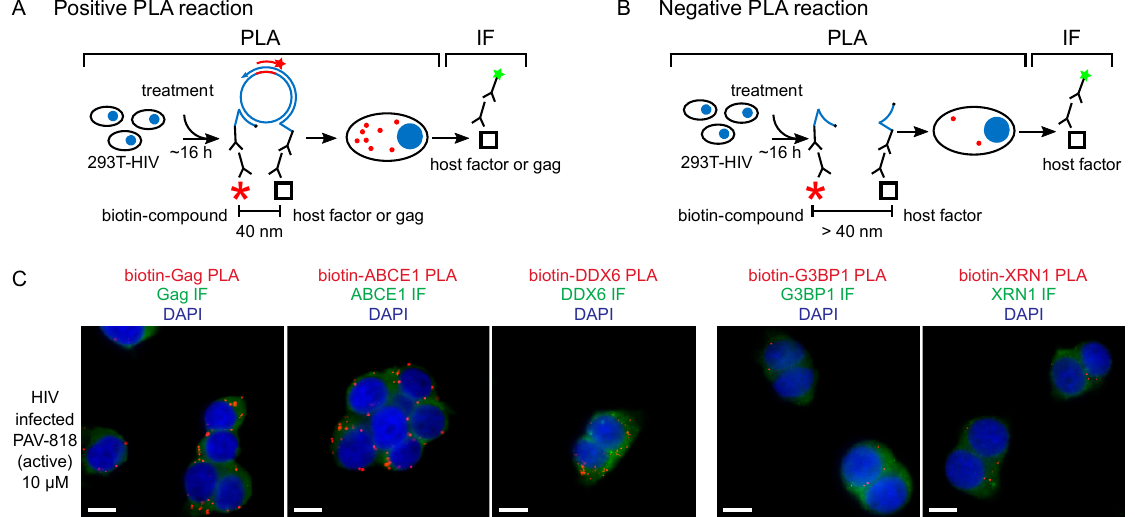
Figure 5. The biotinylated antiretroviral analog of PAV-206 colocalizes with three components of assembly intermediates but does not colocalize with two host proteins that are not associated with Gag or assembly intermediates [29]. ( A ) Schematic of the PLA approach for detecting colocalization of PAV-206 with either Gag or the host proteins ABCE1 and DDX6. 293T cells chronically infected with HIV-1 (293T-HIV) were treated with 10 µ M PAV-818 (the biotinylated active compound). PLA was performed on treated cells by incubating with primary antibody pairs (either rabbit anti-biotin with mouse anti-Gag; mouse anti-biotin with rabbit anti-ABCE1; or mouse anti-biotin with rabbit anti-ABCE1) followed by incubation with PLA secondary antibodies (anti-rabbit IgG coupled to [+] PLA oligonucleotide and anti-mouse IgG coupled to [ − ] PLA oligonucleotide). Addition of other PLA reagents results in connector oligonucleotides annealing to the “+” and “–” oligonucleotides only if the primary antibodies are colocalized (within 40 nm); this in turn leads to the PLA amplification reaction. The addition of an oligonucleotide that recognizes a sequence in the amplified regions and is coupled to a red fluorophore (red star) results in intense spots only at sites where the two antibody targets (biotinylated compound and Gag, or biotinylated compound and host protein) are colocalized in situ. After PLA, IF was performed by adding secondary antibody conjugated to a green fluorophore (green star) to detect any unoccupied Gag or host protein antibody, thus marking Gag- or host-protein expressing cells with low-level green fluorescence. ( B ) This schematic illustrates a scenario in which the biotinylated compound and host protein are more than 40 nm apart. The connector oligonucleotide will not anneal to the antibody-conjugated [+] and [ − ] PLA oligonucleotides; thus, little to no amplification will occur and few or no red spots will be observed. ( C ) Data in the three panels on the left show colocalization by PLA of Gag, ABCE1, and DDX6 with PAV-818, respectively. Data in the two panels on the right show lack of colocalization with two host proteins that are found in P-bodies and stress granules, respectively, G3BP1 and XRN1, but are not known to be associated with Gag or found in assembly intermediates. Additional PLA negative controls, PLA dose–response curves, and quantitation are found in